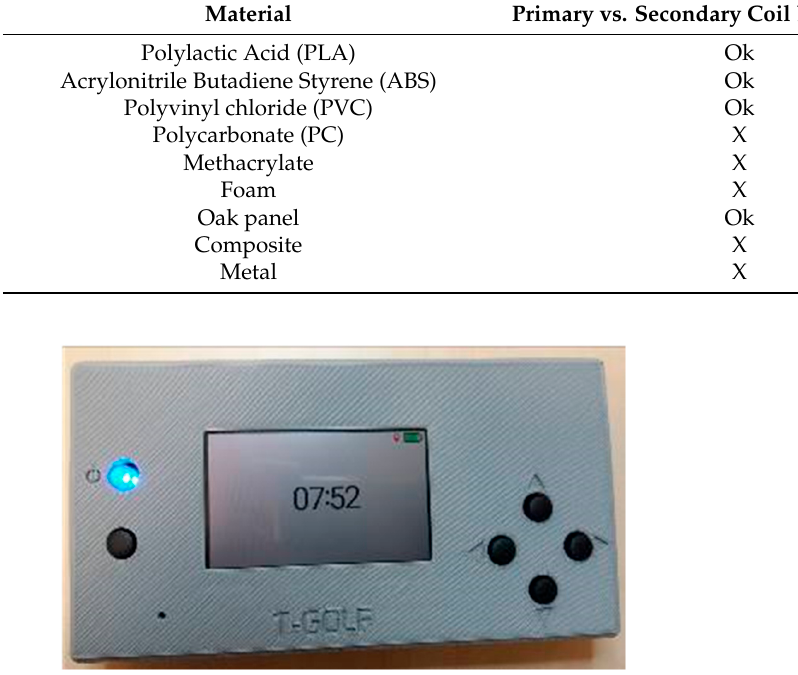
Table 5. Results of tested encapsulation materials for the WPT system.